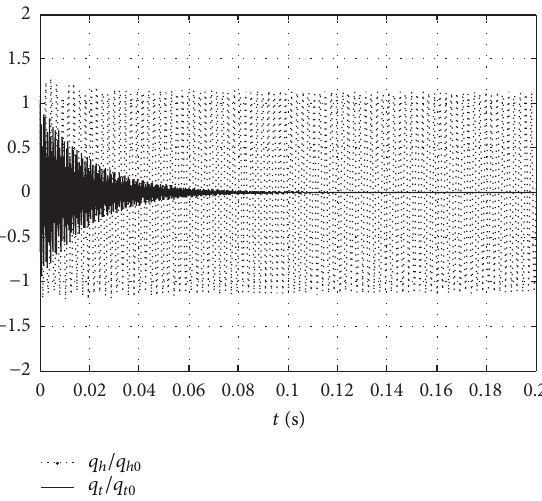
Figure 7: Velocity versus time plot of the generalized coordinate of thebeamwithoutpiezoelectricattachment, 𝑈 = 95 m/sand 𝑉 𝑞ℎ (0) = 𝑉 ℎ0 .